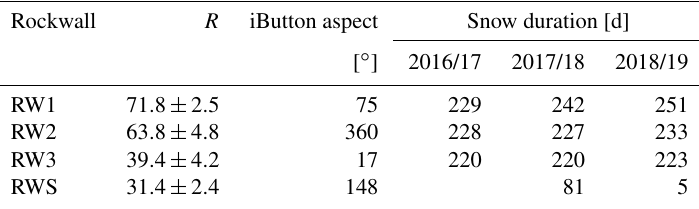
Table 3. Schmidt hammer rebound values R , aspect of installed iButtons and calculated snow duration at each rock surface temperature